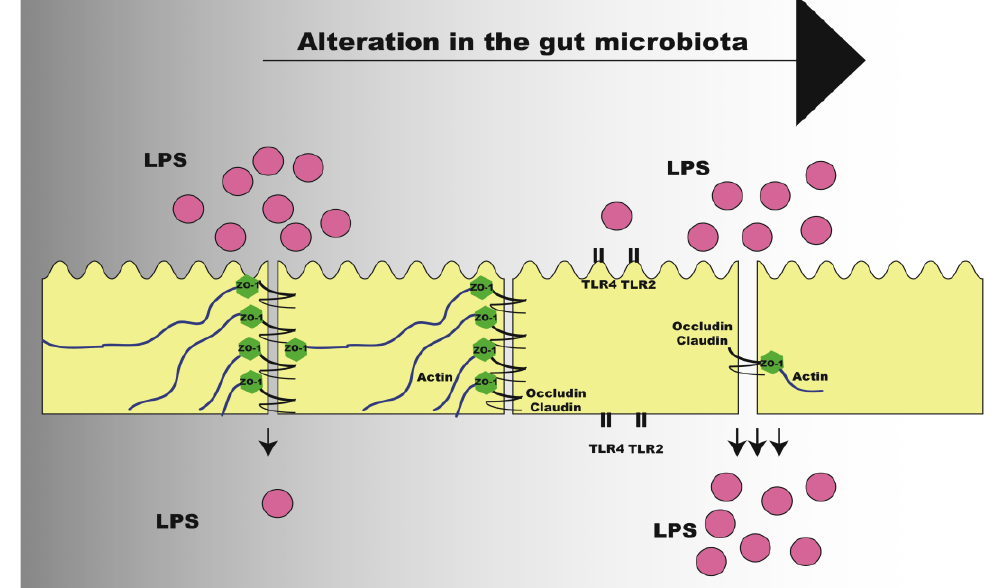
Figure 4. Alteration of intestinal permeability after change in gut microbiota of obese individuals. LPS: lipopolysaccharide; TLR: Toll-like Receptor; ZO-1: zonula